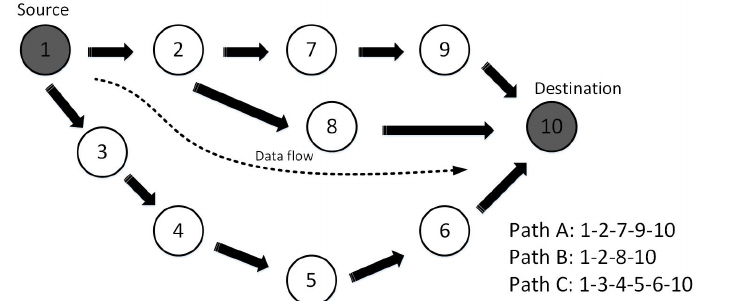
Figure 3. Communication Path in WBAN: A glimpse of a normal communication taking place in the network. The path B from source to destination is selected for